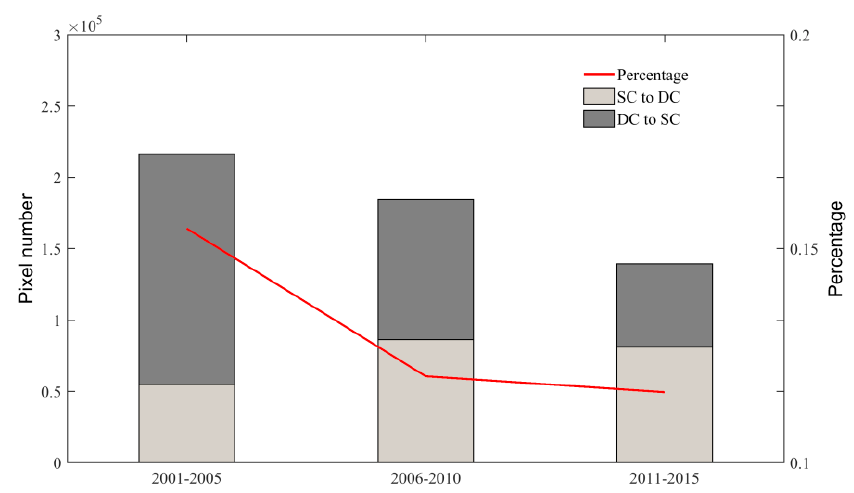
Figure 13. The amount and their percentage transferred between SC and DC.